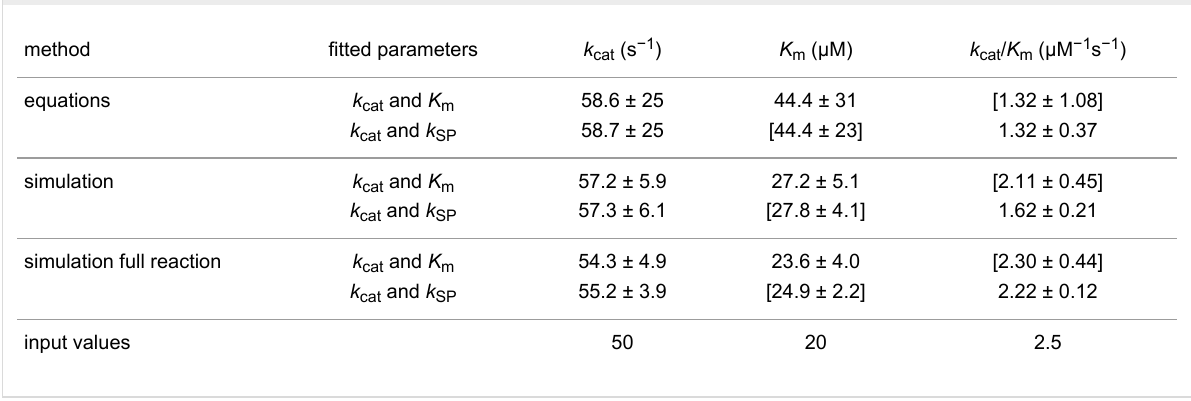
Table 1: Summary of fitted parameters. Synthetic data were generated as described in the text and then fit to derive estimates of steady state kinetic parameters using different equations and different means of data fitting. Here we list the methods for fitting and the chosen fitted parameters for each method. The values for k cat , K m and k cat / K m are shown. Values in brackets were calculated from the other parameters. For example, in the first row, k cat / K m was calculated from k cat and K m , whereas in the second row, K m was calculated from estimates of k cat and k cat / K m . Standard error estimates for calculated parameters were obtained by propagation of errors as described in the text. Note that the fitted parameters need not reproduce the input parameters used to generate synthetic because of the added errors and the limited set of data. A more complete data set with lower errors would return the input